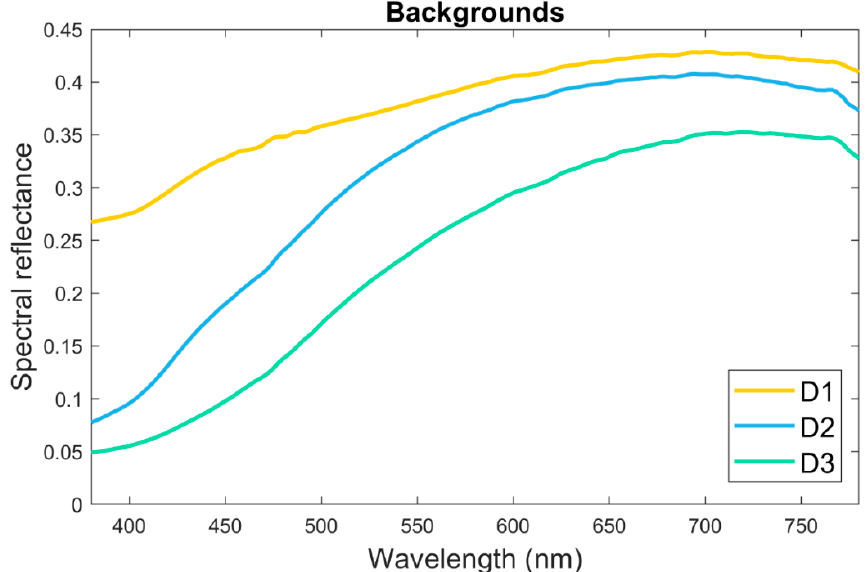
Figure 1. Spectral reflectance of the three natural teeth used as background. The color of natural teeth used as backgrounds was also determined with a calibrated digital spectrophotometer (EspectroShade™ Micro, MHT, Arbizzano di Negrar, RV, Italy) as 0M3/B1, 3M3/B3, and 5M3/B4 for D1, D2, and D3, according to the VITA 3DMaster and VITA Classical shade guides, respectively.